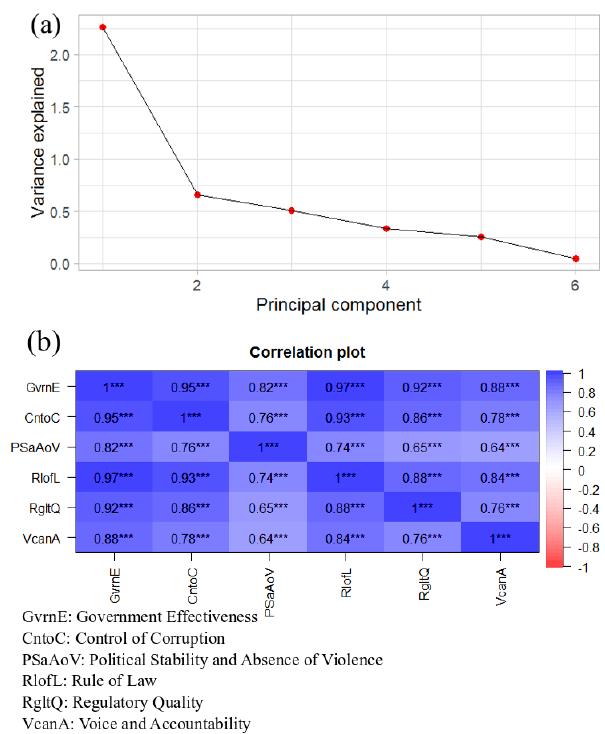
Fig. 2 . Principal component analysis (a) and correlation plot (b) for institutional quality